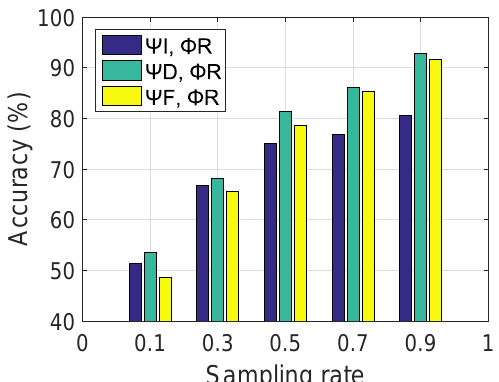
Figure 5. The reconstruction accuracy of link quality matrix with compressive sensing in Φ R with variant Ψ s: identity matrix ( Ψ I ), Fourier transform matrix ( Ψ F ), and discrete cosine transform matrix ( Ψ D ). (George Town